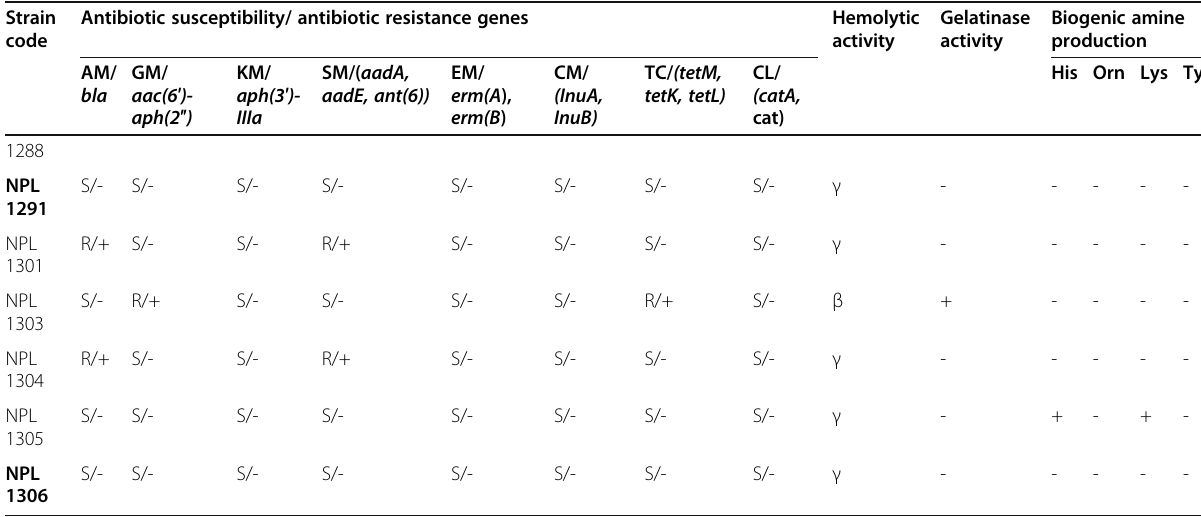
Table 2 Safety assessment of the LAB strains (Continued) Strain code